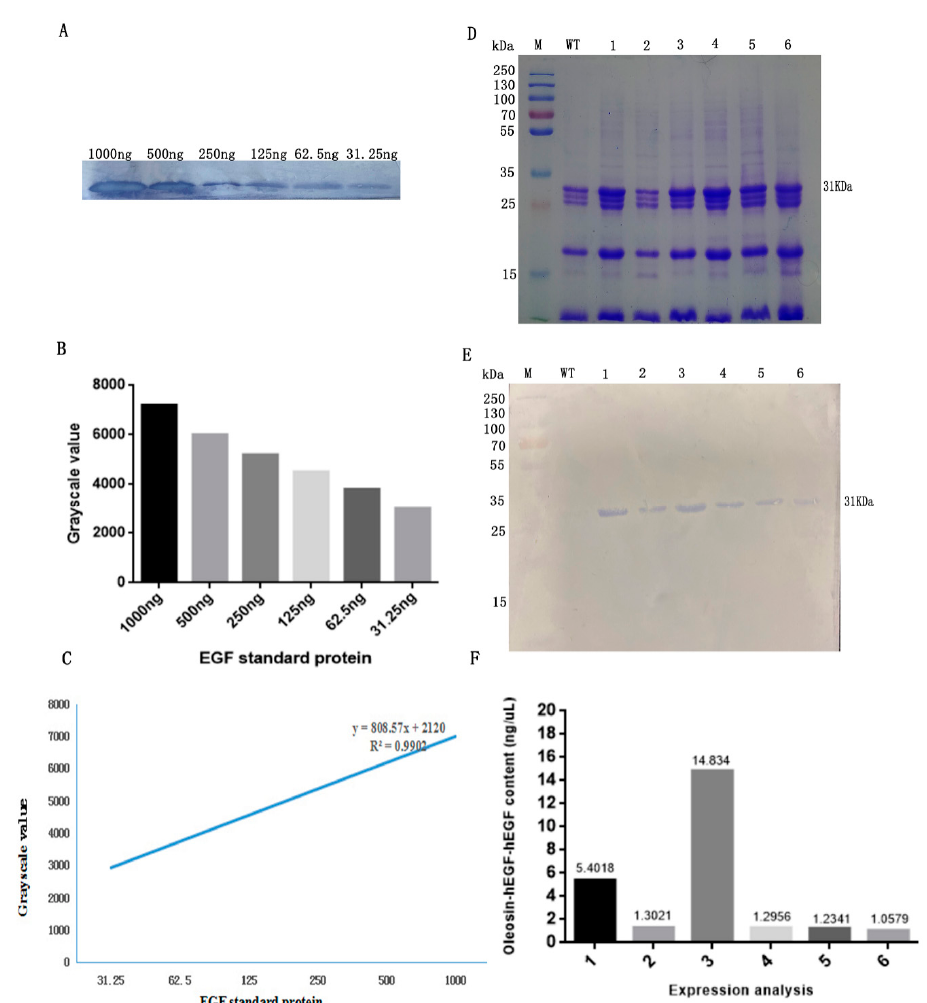
Figure 2. Protein expression from T3 transgenic Arabidopsis. ( A ) western blot; ( B ) grayscale values and ( C ) the standard curve of the grayscale values from various concentrations of hEGF standard protein; ( D ) SDS-PAGE of the oil body; ( E ) western blot of fusion protein and ( F ) quantitation of fusion protein from T3 Arabidopsis seeds. M—protein marker; 1–6—oil body in T3 Arabidopsis; WT—oil bodies from WT Arabidopsis.